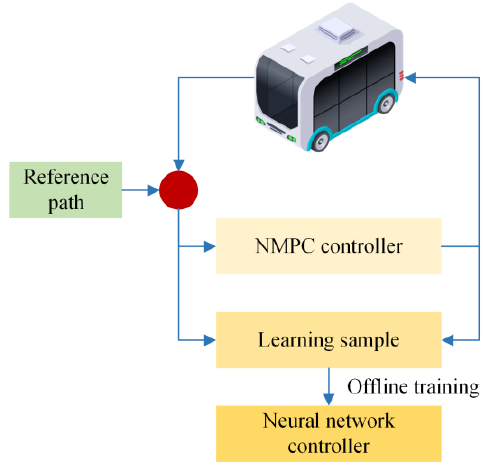
Figure 2. The training principle of the neural network path tracking controller.